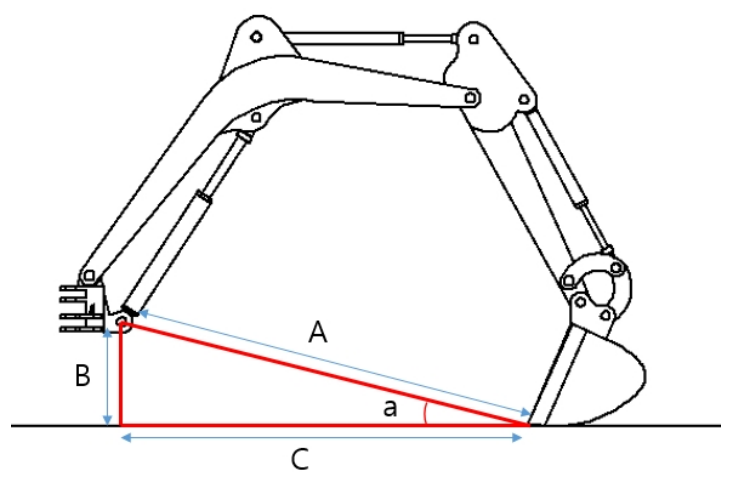
Figure 5. Reference for validation of the CAD model: ( A ) diagonal; ( B ) height; ( C ) length; and ( a ) the angle created by A and